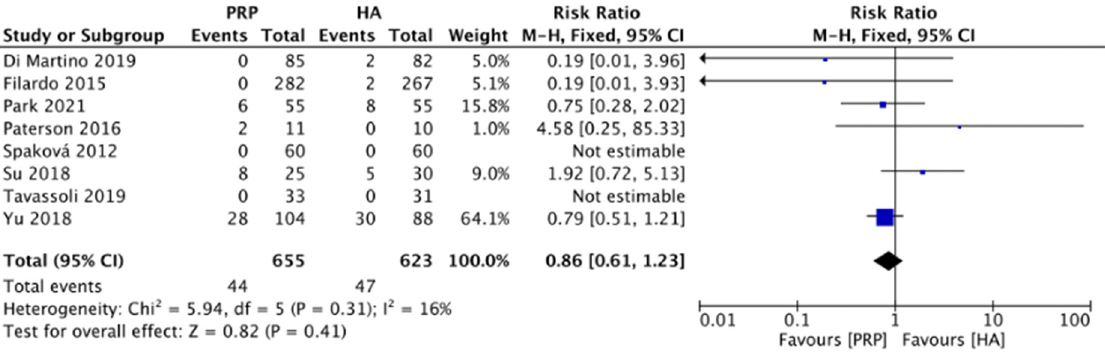
Figure 10. Trials of LR-PRP versus HA. Forest plot of adverse effects. (M-H: Mantel Haenszel; CI, confidence interval).